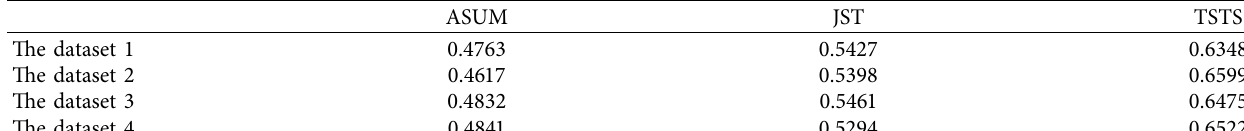
Table 4: Accuracy of sentiment polarity judgment.